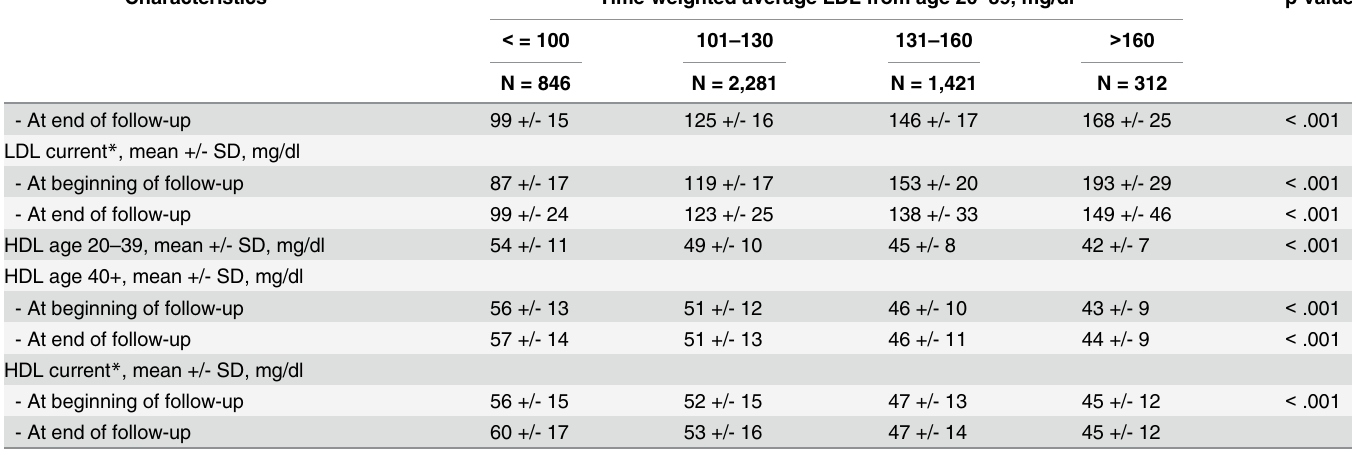
associated with CHD events in the full model (p-trend = 0.28 – 0.47), a test of the overall con- tribution of all HDL variables to the model was highly significant (p = 0.0013, Fig 1). When only the young adult HDL variable was included in the model, it was highly significant (Table 3); the same is true for current HDL (HRs 1.3 – 2.1, p-trend < .001). In the full model, the two later life LDL variables (time-weighted average after age 40, and current level) were not independently associated with the outcome (Fig 1), but these variables were strongly cor- related (Table A in S1 Appendix), and a joint test of significance for both of these later life LDL variables was borderline significant (p = .053). When we dropped the time-weighted average after age 40 variable, the current level variable became significantly associated with the outcome (p for trend = 0.017), and the early life LDL association became even stronger (p for trend = .0005). Sensitivity analyses demonstrated consistent patterns of association. When we limited our analysis to only the 2969 participants with at least one direct risk factor measurements before age 40, point estimates were similar or even larger for early adult DBP (HRs 1.5 – 4.4, p- trend = 0.03) and LDL (HRs 2.1 – 3.0, p-trend = 0.05) and remained null for early adult SBP and HDL (see Table E in S1 Appendix for a full tabulation of results). When early adult DBP was omitted from the model, early adult SBP remained only marginally associated with CHD events (HRs 1.3 – 1.4, p-trend = 0.39). Among the 2667 participants who never reported using blood pressure or lipid medications, early adult LDL remained significantly associated with CHD events (HRs 1.3 – 3.4, p-trend = 0.03) but DBP did not, although the HRs were similar in magnitude (HRs 1.2 – 2.6, p-trend = 0.52); only 12 participants in this subgroup had early adult DBP > 90. Among early adult risk factors, only DBP interacted significantly with gender (p < .001); but only 55 men had early adult DBP < = 70, and none of these men had CHD events. When this variable was recoded collapsing categories < = 70 with 71 – 80, no interaction was noted (p = 0.52). In a model containing continuous instead of categorical risk factors, we found no evidence of non-linearity in any of the predictors, and the significant predictors were the same: current SBP HR = 1.3 (1.1 – 1.6) per 20 mmHg, early adult DBP HR = 1.6 (1.1 – 2.3) per 10 mmHg, and early adult LDL HR = 1.5 (1.1 – 2.0) per 30 mg/dl. Using continuous predictors